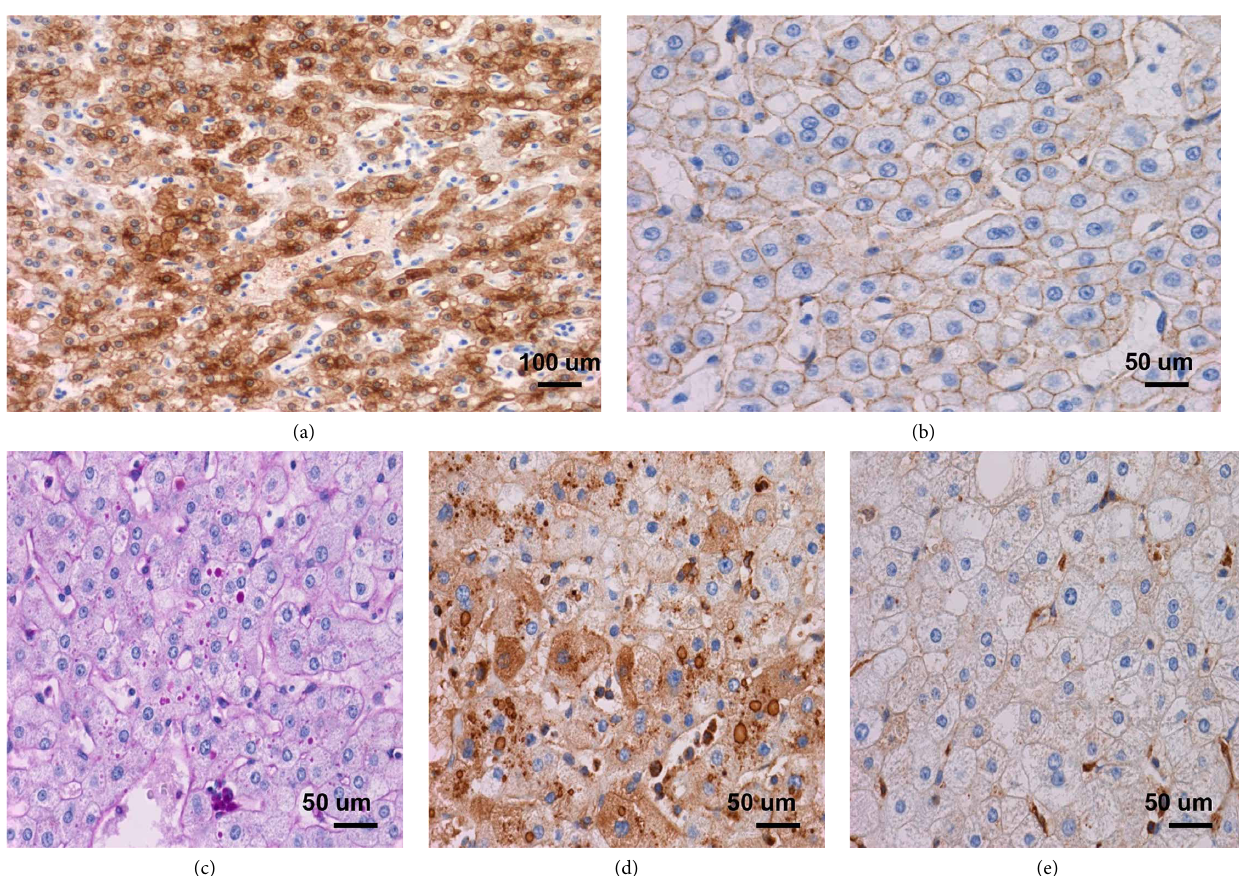
Figure 2: The hepatocellular adenoma is further subtyped as β -catenin activated HCA. (a) Immunostaining for glutamine synthetase shows diffuse reactivity within the tumor (200x), (b) β -catenin immunostain is negative for nuclear staining (400x). Intracytoplasmic globules in focal areas of the hepatocellular adenoma are observed. (c) PAS-D stain highlights small PAS positive and diastase resistant cytoplasmic globules (400x). These globules are immunoreactive with alpha-1-antitrypsin (d) but not alpha-1-antichymotrypsin (e)